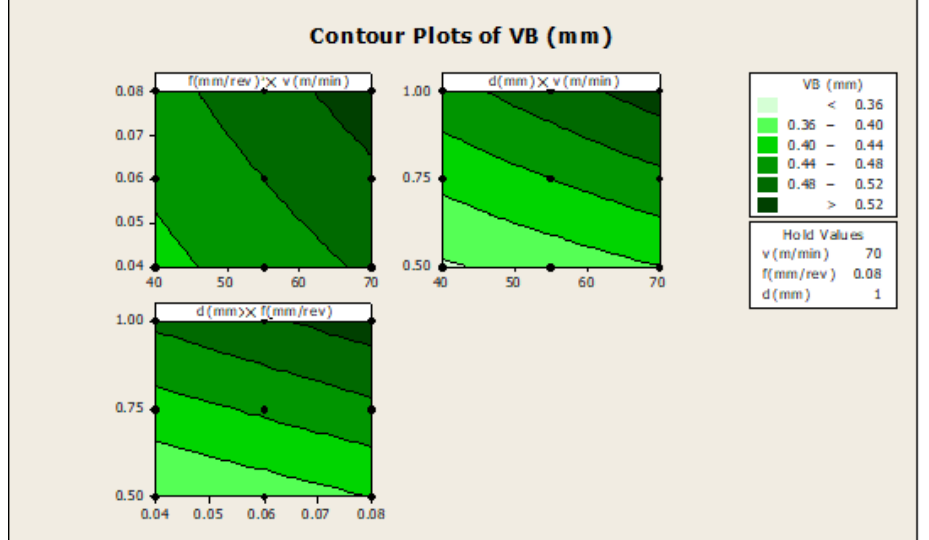
Figure 3. Contour plots for VB. In Figure 4 , the plot indicates how variables such as feed rate and cutting speed are related to the F X , while other factors such as depth of cut (d) are held constant, (f × v) at a high value of 1. The response is at its highest (greater than 70) in the darkest region of the graph (the upper left-hand corner). In , the plot indicates how variables such as depth of cut and cutting speed are related to the F X , while others such as the feed-rate (d × v) factor are held constant, at a high value of 0.08. The response is at its highest (greater than 70) in the darkest region of the graph (the upper left-hand corner). In , the plot indicates how variables, such as depth of cut and feed rate are related to the Fx while (d × f) other factors such as cutting speed are held constant, at a high value of 70. The response is at its highest (between 50 and 60) in the dark region of the graph (the uppermost cor- ner).